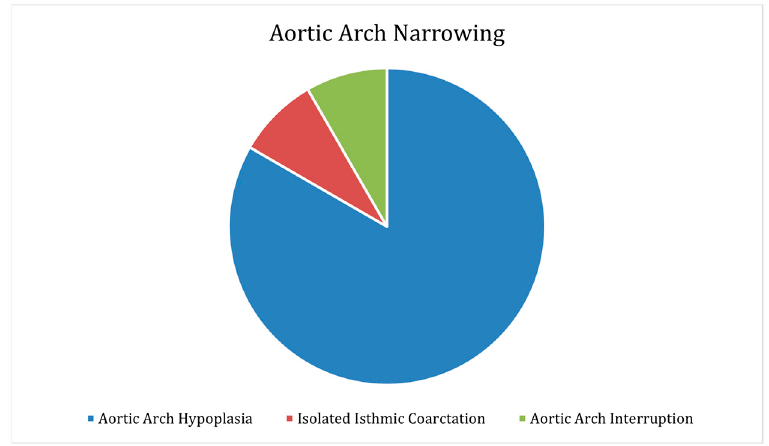
Figure 4. Aortic arch narrowing, including aortic arch hypoplasia, isolated isthmic coarctation, and aortic arch interruption.